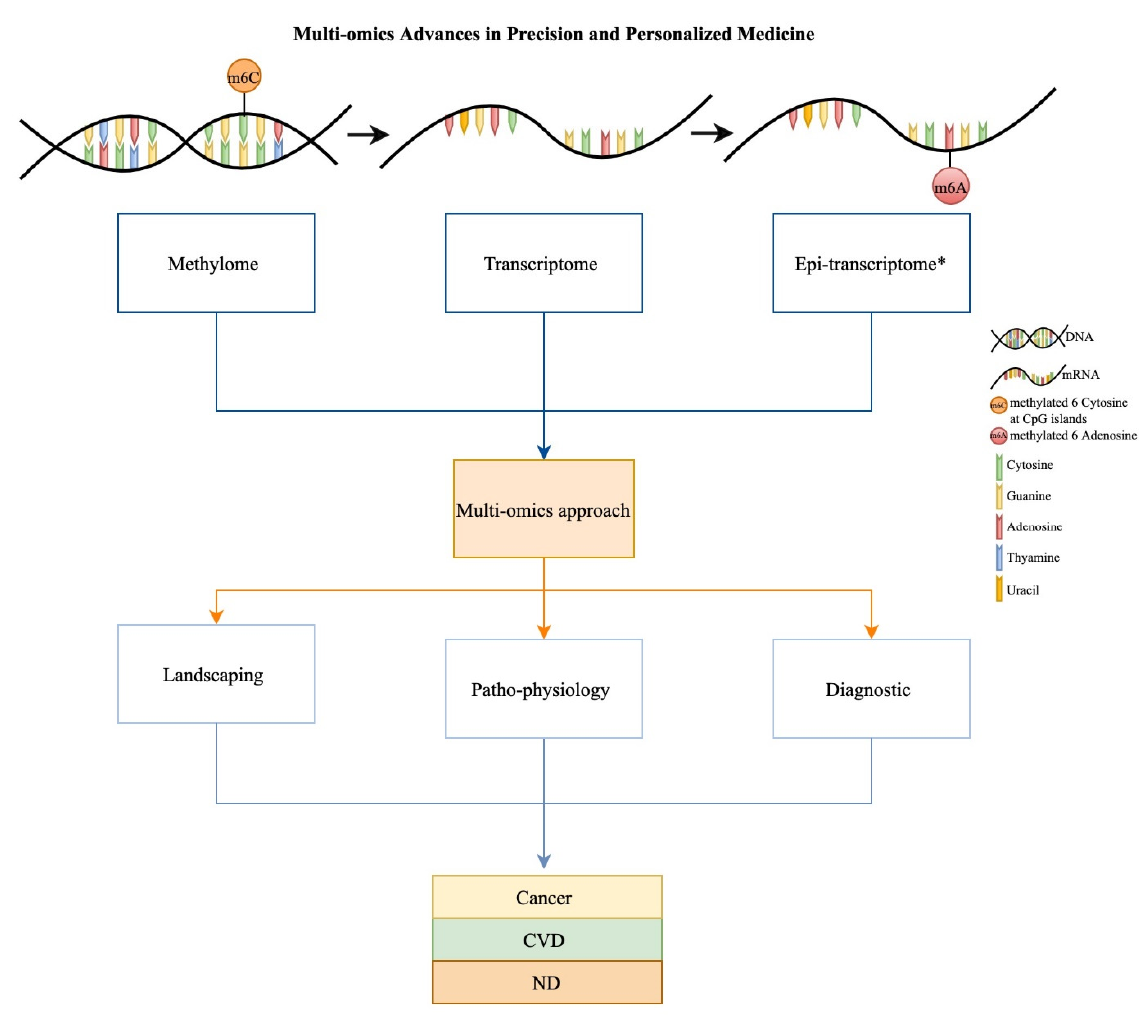
Figure 1. Multi-Omics advances in precision and personalized medicine.